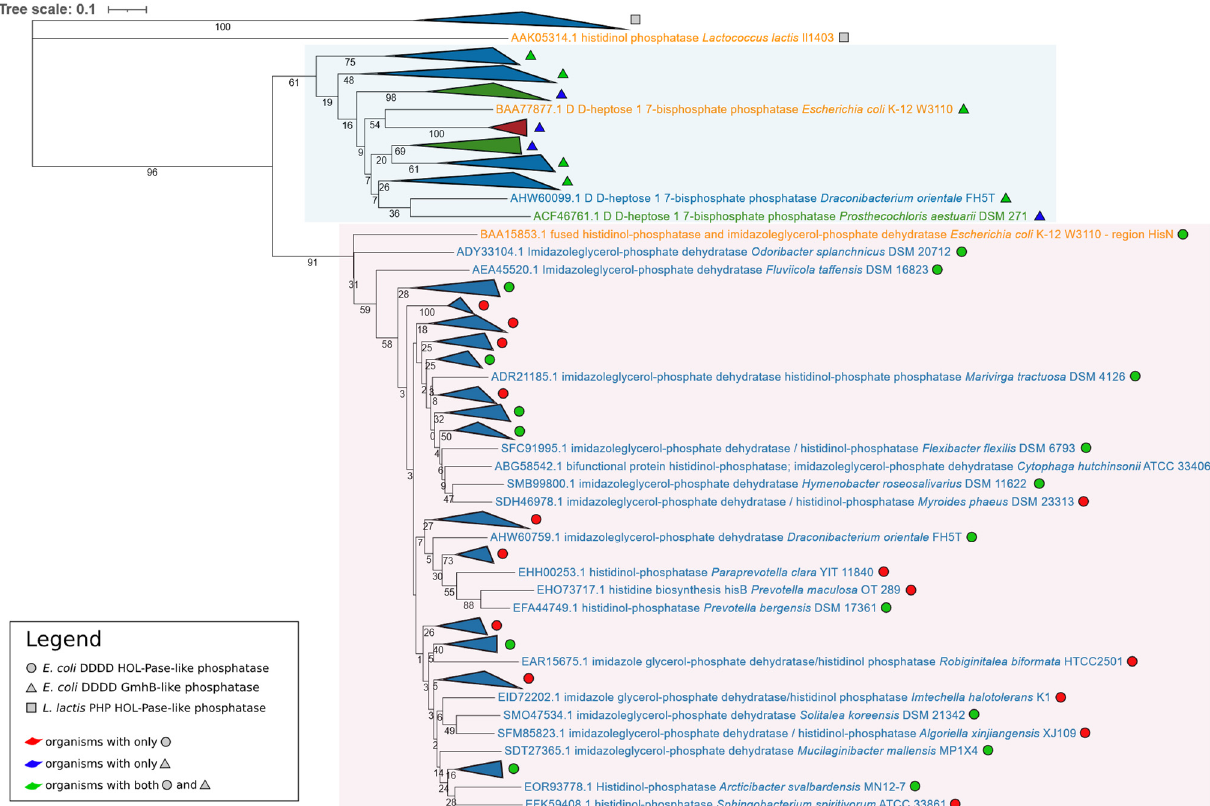
Figure 1. Phylogenetic tree based on the 125 phosphatase amino acid sequences retrieved from the BLASTp search using L. lactis PHP HOL-Pase, E. coli DDDD HOL-Pase, and E. coli DDDD GmhB as queries. After the multialignment trimming, 201 positions have been considered for the phylogenetic tree construction. Organisms belonging to the same taxonomic group and with the phosphatase belonging to the same family have been collapsed (the entire phylogenetic tree is available in Supplementary File S21, Figure S1). Colors light blue and pink identify the two main clusters. Proteins reported in orange are those from the tree queries, those in blue are from Bacteroidetes, those in green are from Chlorobi, and those in red are from Balneolota.